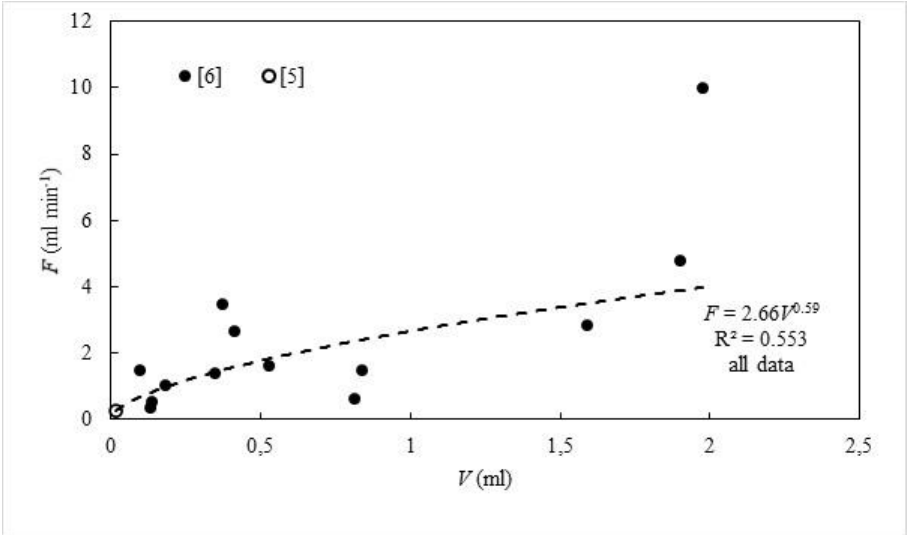
Figure 3. Halichondria panicea . Filtration rate ( F ) of single-osculum explants as a function of sponge- body volume ( V ). The power-function regression line has been shown along with its equation. The b 3 -exponent is 0.59, which may be compared to the model-predicted b 3 = 2/3 [5,6] (LM, t 0.2964, 12 = 4.099, p = 0.0015).